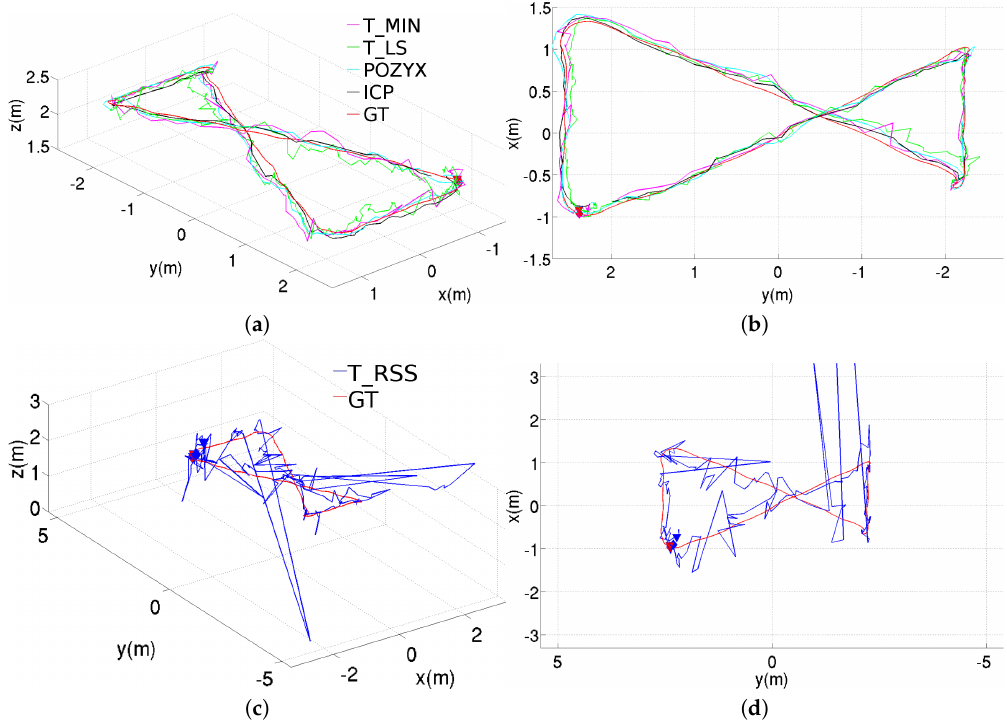
Figure 6. Position estimations provided by the different methods for the figure-eight-like trajectory using the standalone configuration, results for the T_RSS method are shown separately to facilitate the comparison: ( a ) perspective and ( b ) top views for T_MIN, T_LS, POZYX and ICP, ( c ) perspective and ( d ) top views for